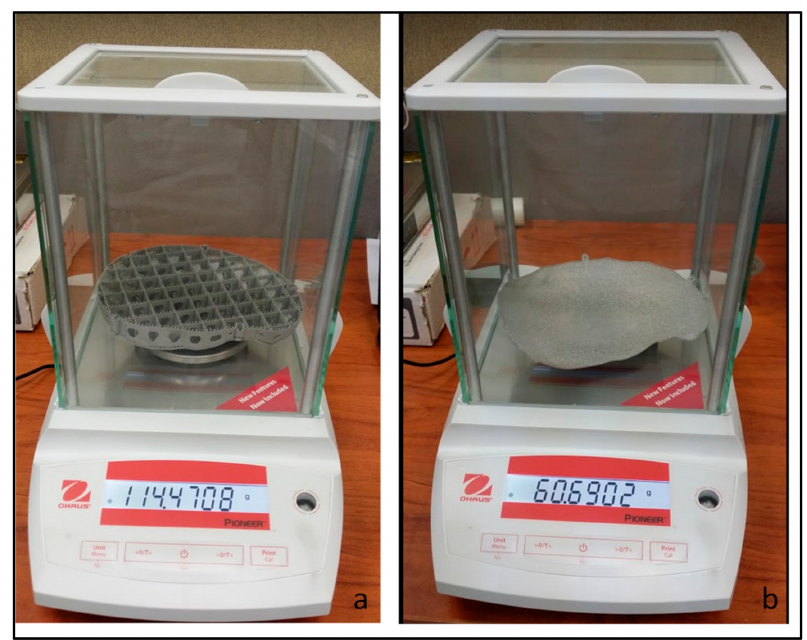
Figure 11. Weighing scale reading of cranial implants ( a ) with supports and ( b ) without